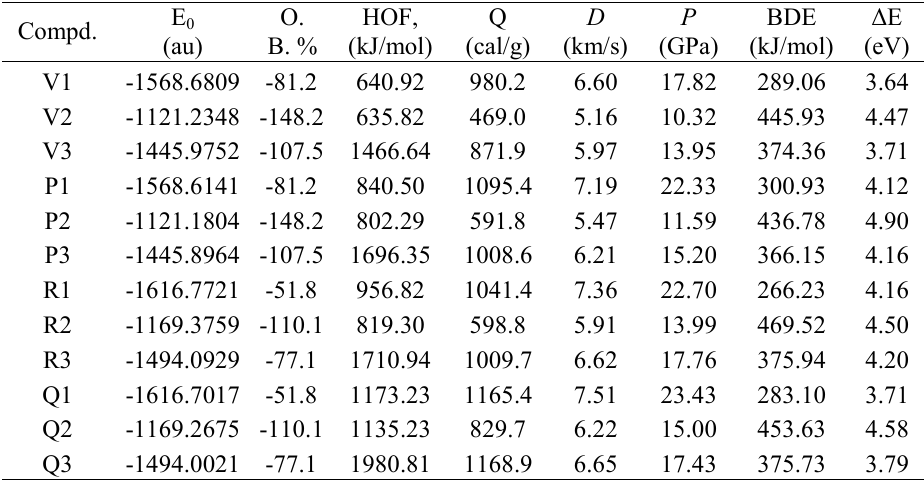
Table 2. Calculated energetic properties of the designed s-triazine derivatives.